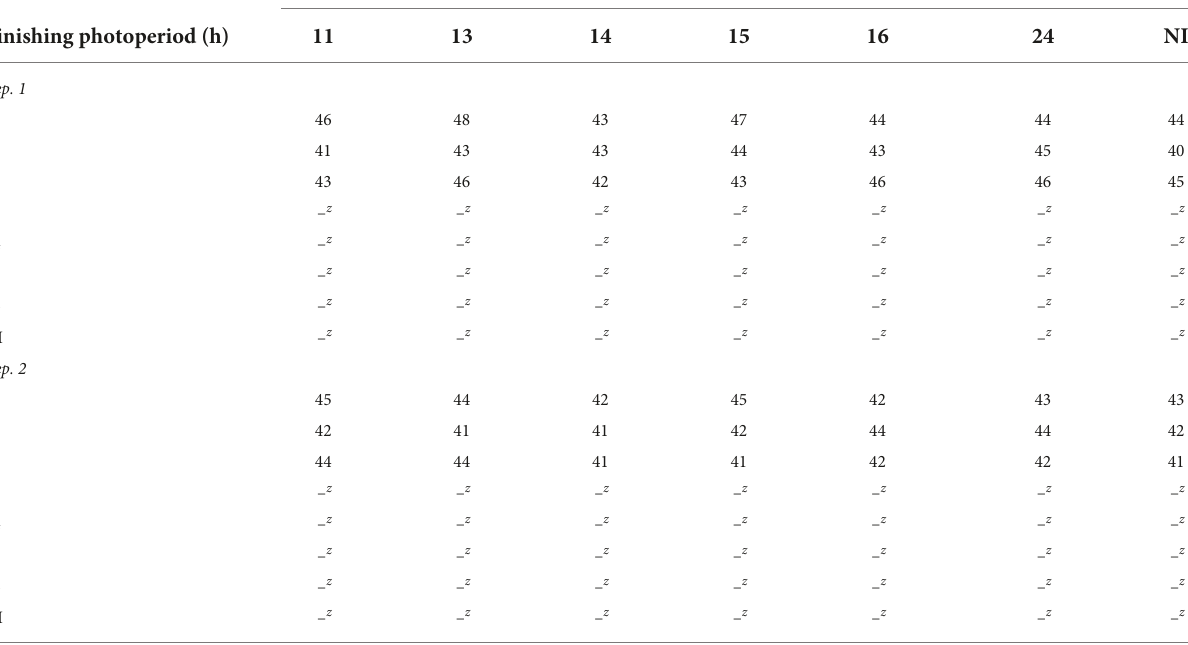
TABLE 6 Effects of young-plant photoperiod (11, 13, 14, 15, 16, or 24 h, or a 4-h NI) and finishing photoperiod (10, 11, 12, 13, 14, 15, and 16 h, or a 4-h NI) on time to harvest (d) of marigold ‘Xochi’ ( Tagetes erecta ). Young-plant photoperiod (h)